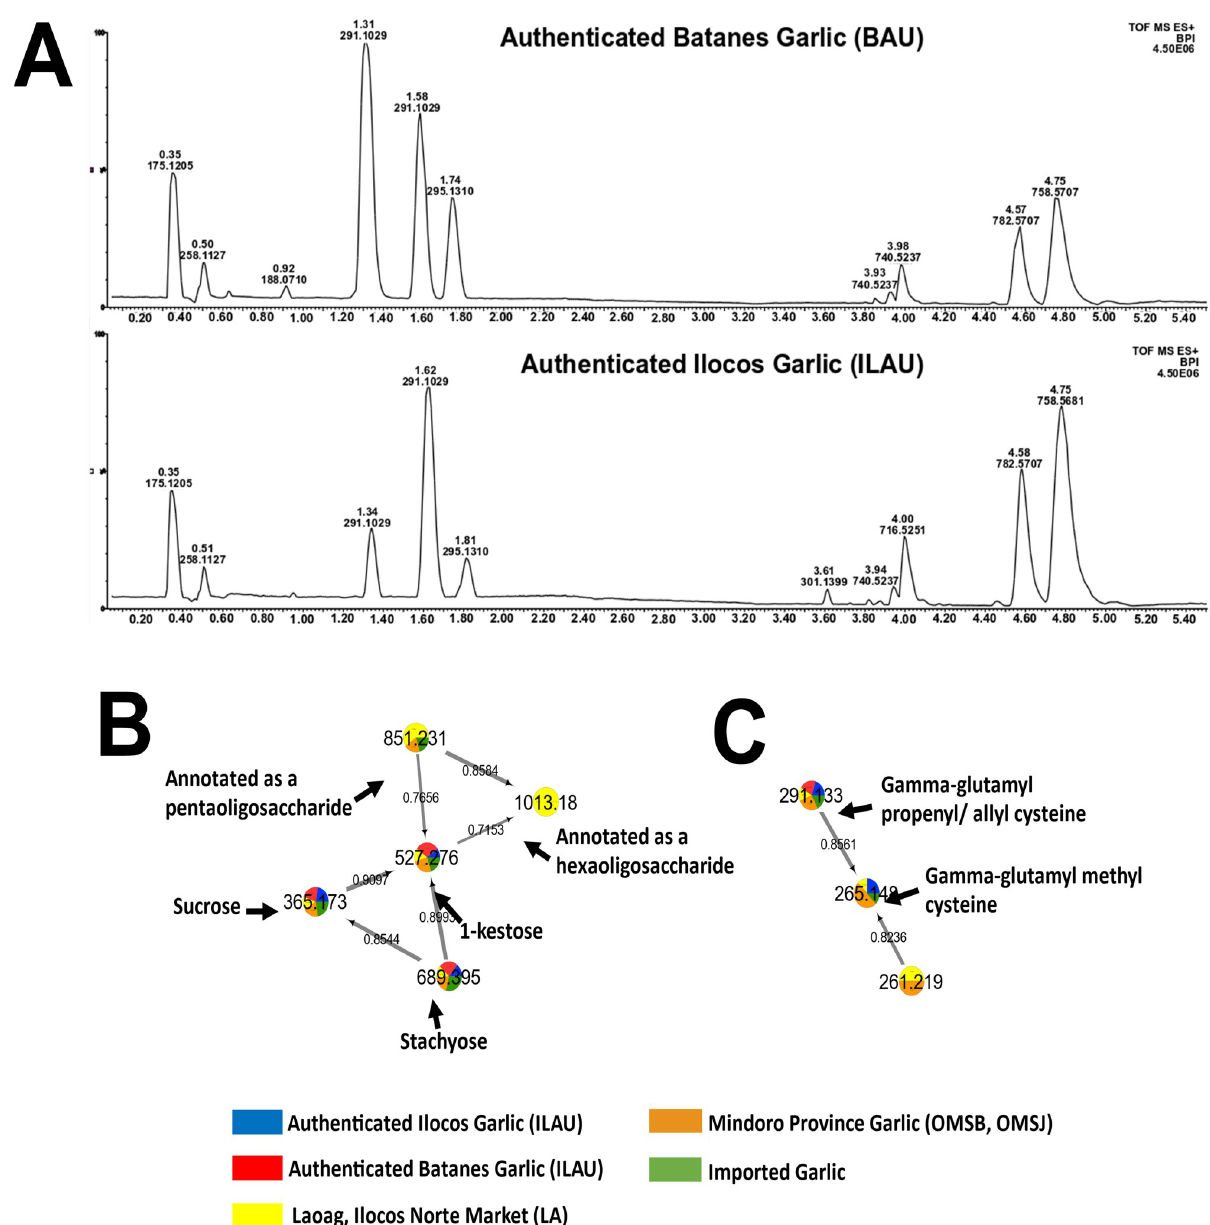
Fig 1. Base peak chromatograms of authenticated garlic samples and resulting molecular networks with putatively annotated oligosaccharides and dipeptides. Full-scan profiles of authenticated Batanes (BAU) and Ilocos (ILAU) garlic were shown in (A). GNPS generated networks with putatively annotated oligosaccharides and γ -Glu dipeptides are illustrated in (B) and (C), respectively.